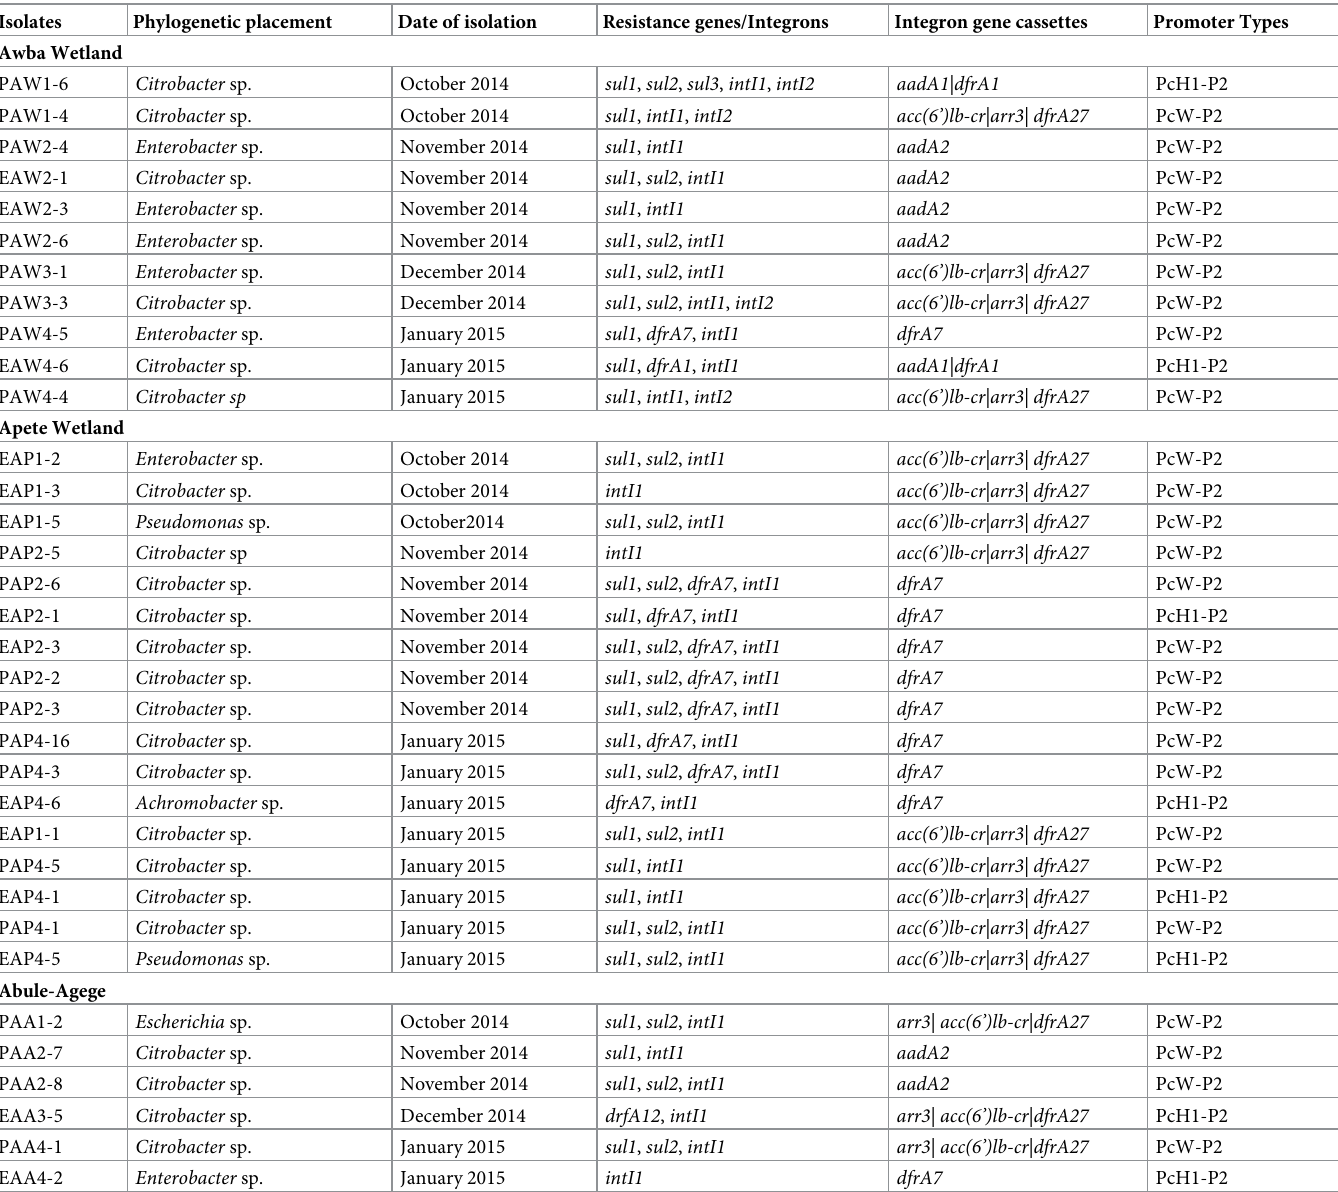
Table 1. Resistance genes, class 1 integron gene cassettes and promoter types in SMX/TRI-resistant bacteria from the four wetlands in Ibadan and Lagos, Nigeria. Isolates Phylogenetic